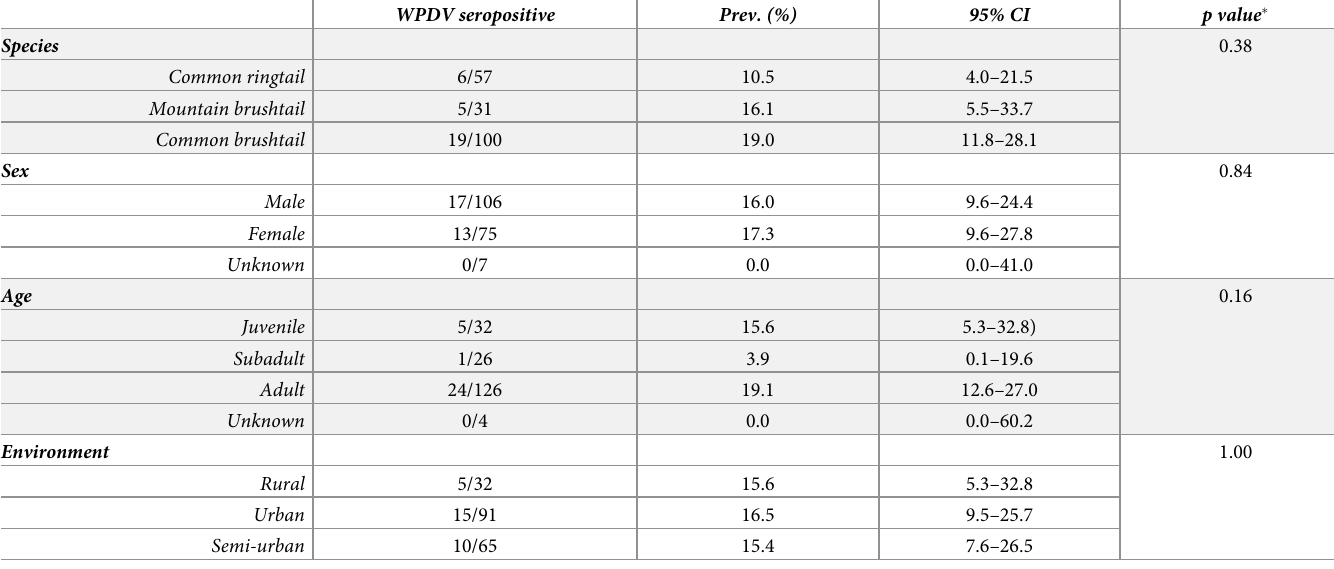
Table 1. Seroprevalence results and statistical analysis assessing individual epidemiological variables for wobbly possum disease virus seropositivity in a sample of Australian possums (n = 188), using the cut-off value of corrected OD 450 > 0.41 for positive